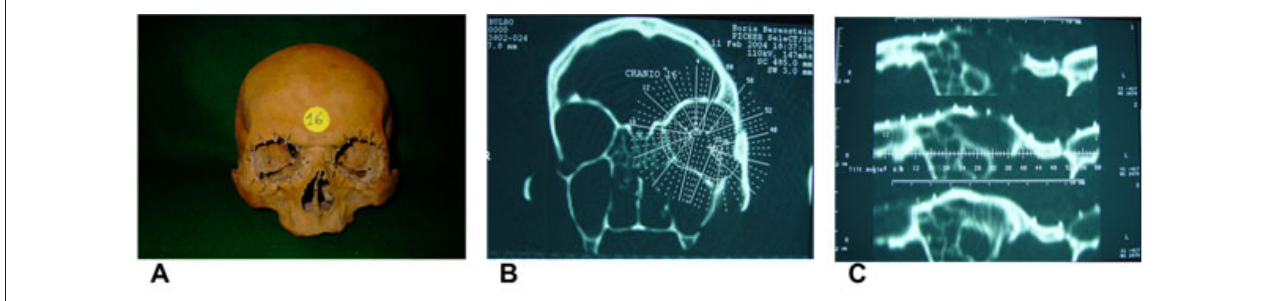
Fig. 2 - Skull and computed tomography scan of the left orbit. A - Skull with the demarcated right and left peri-orbital regions; radiopaque points determined in accordance with the marking provided by the locator; - B - location and delineation of the anatomical points; C - scale showing the sequence of reconstructions (from 1 to 60) with the respective correspondence of the radiopaque images of the repair points fixed in each